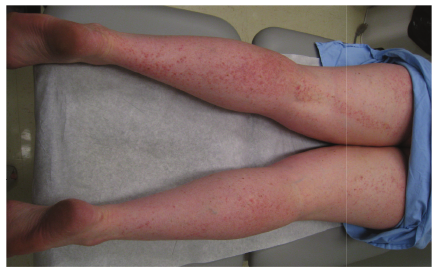
Figure 1: Posterior lower limbs demonstrating segmental linear plaques of warty papules on a background of less prominent hyperkeratotic papules and plaques.